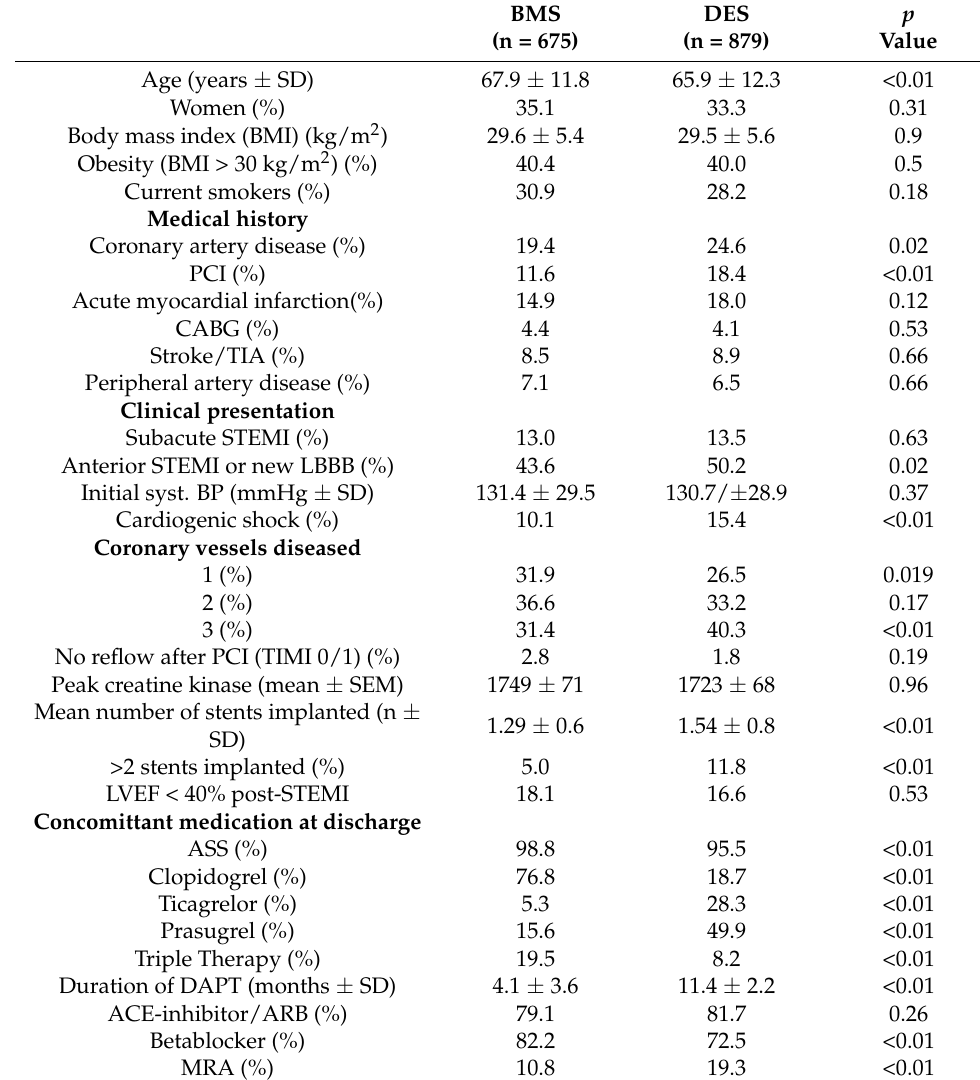
Table 2. Characteristics of diabetic patients with STEMI treated with BMS vs.